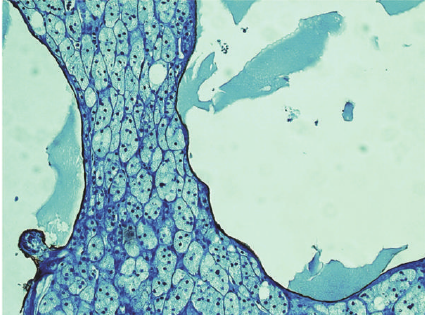
Figure 3: The flattened cells lining the cyst stained positive for D2- 40 ( ×400